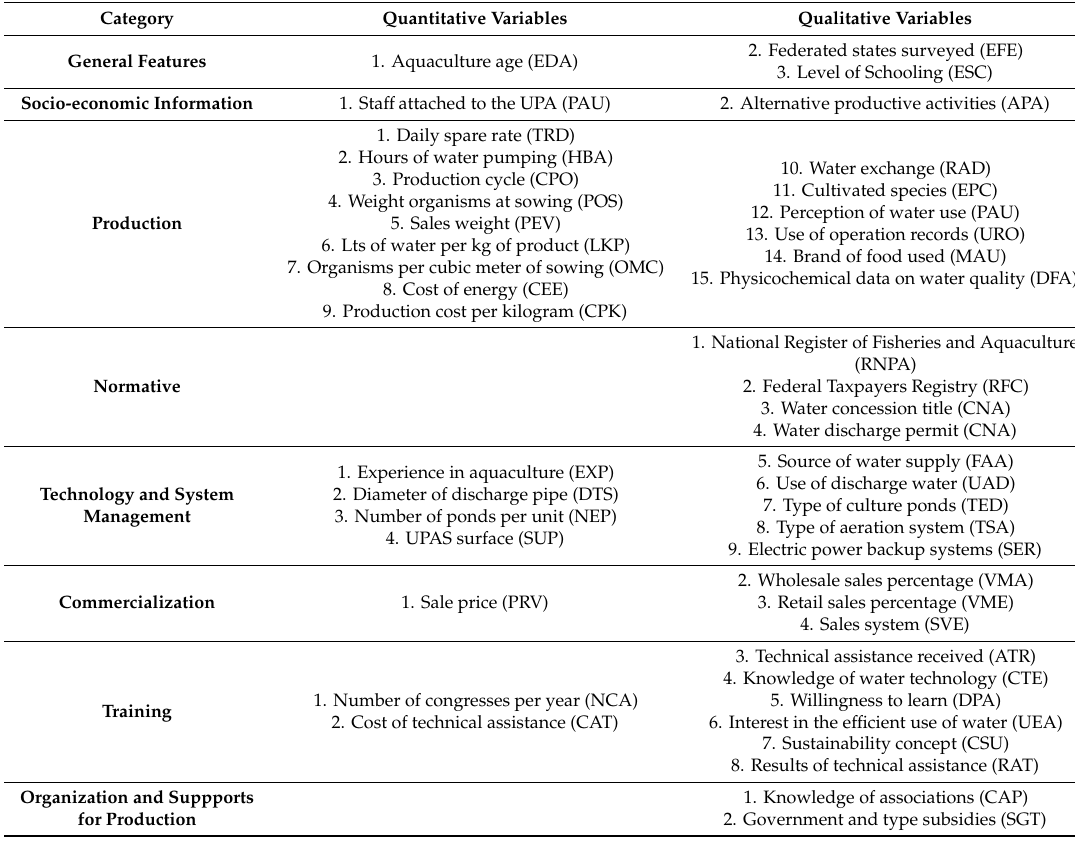
Table 1. Mexican aquaculture production units registered in the National Registry of Fisheries and Aquaculture (UPA-RNPA by its initials in Spanish). Categories